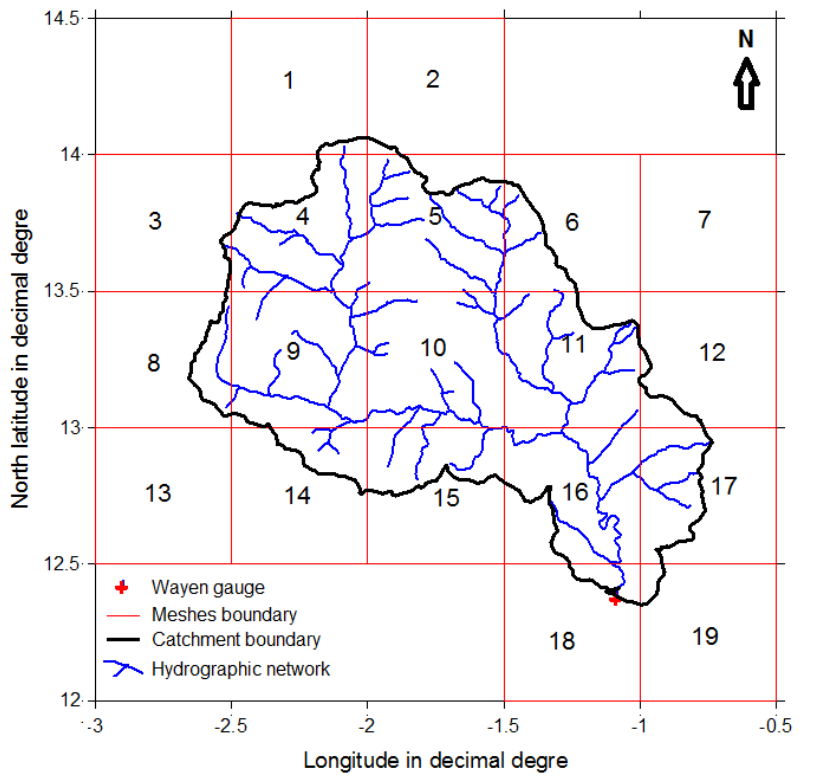
Figure 3. Subdivision of the Nakanbe basin at Wayen gauge into meshes of 0.5° × 0.5°. The numbers represent the reference index of the mesh, from 1 to